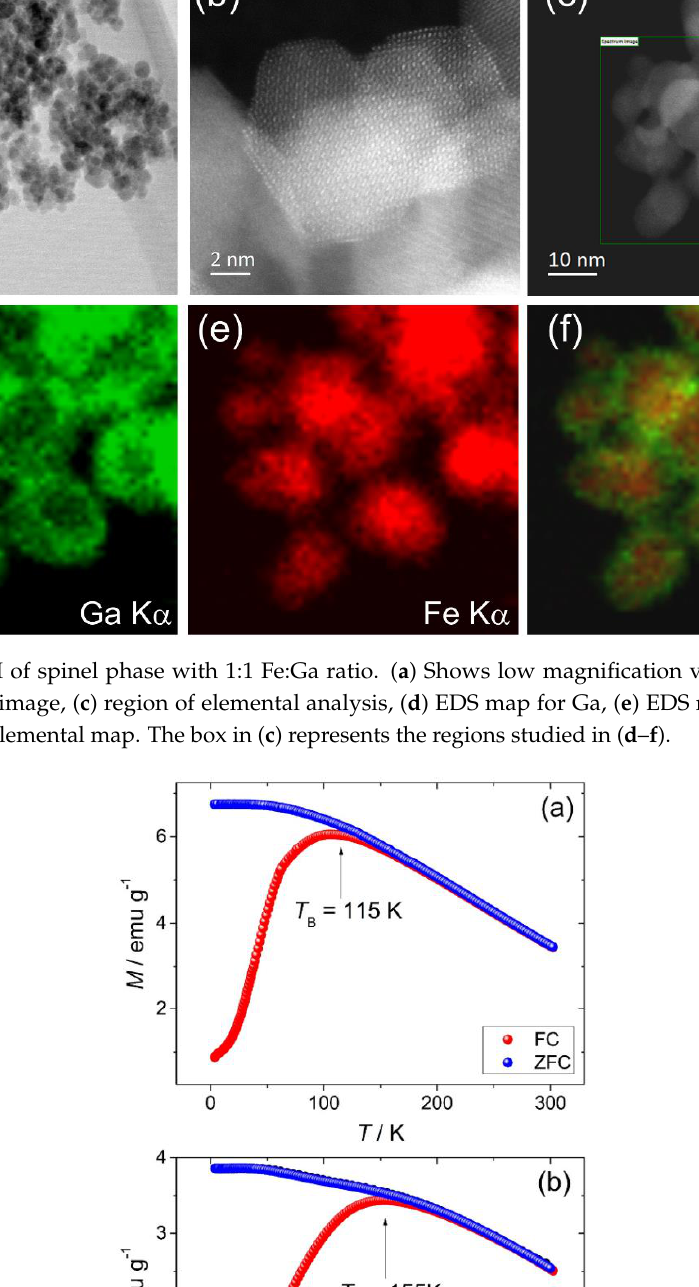
Figure 8. Hysteresis curves measured at 4.2 K (red) and 300 K (blue) of Fe substituted  -Ga 2 O 3 for samples ( a ) Fe:Ga 1:1 and ( b ) Fe:Ga 3:7. The insets show expansion of the curves in the low-field region.